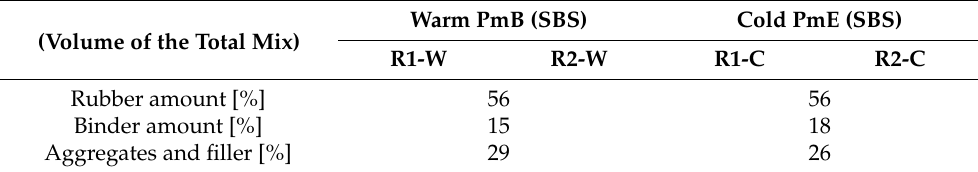
Aggregates and filler [%] 26